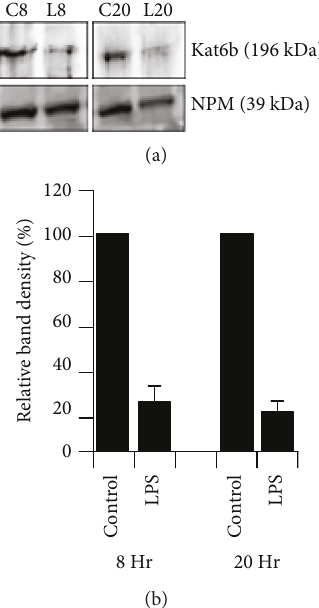
Figure 4: (a) Western blot analysis of the expression of Kat6B in untreated macrophages and macrophages treated with LPS (100ng/ml) for 8 or 20 hours. Kat6B expression was compared to that of nucleophosmin (NPM), a housekeeping gene that is una ff ected by LPS treatment. Samples were analyzed using 3 independent cell extracts, and typical Western blot images are shown. (b) Western blots were scanned and quantitated. Results show means ± SE ( n = 3 ).